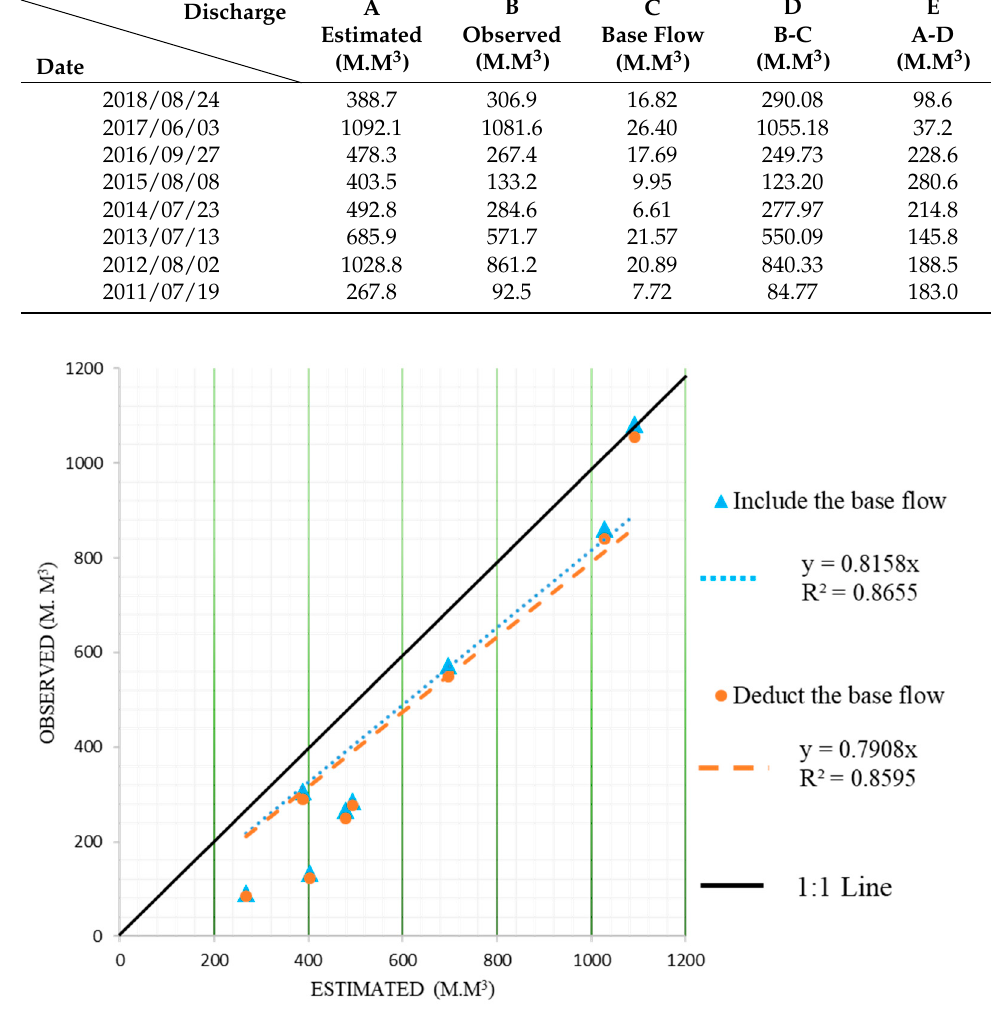
Figure 7. Correlation between estimated runoff and observed